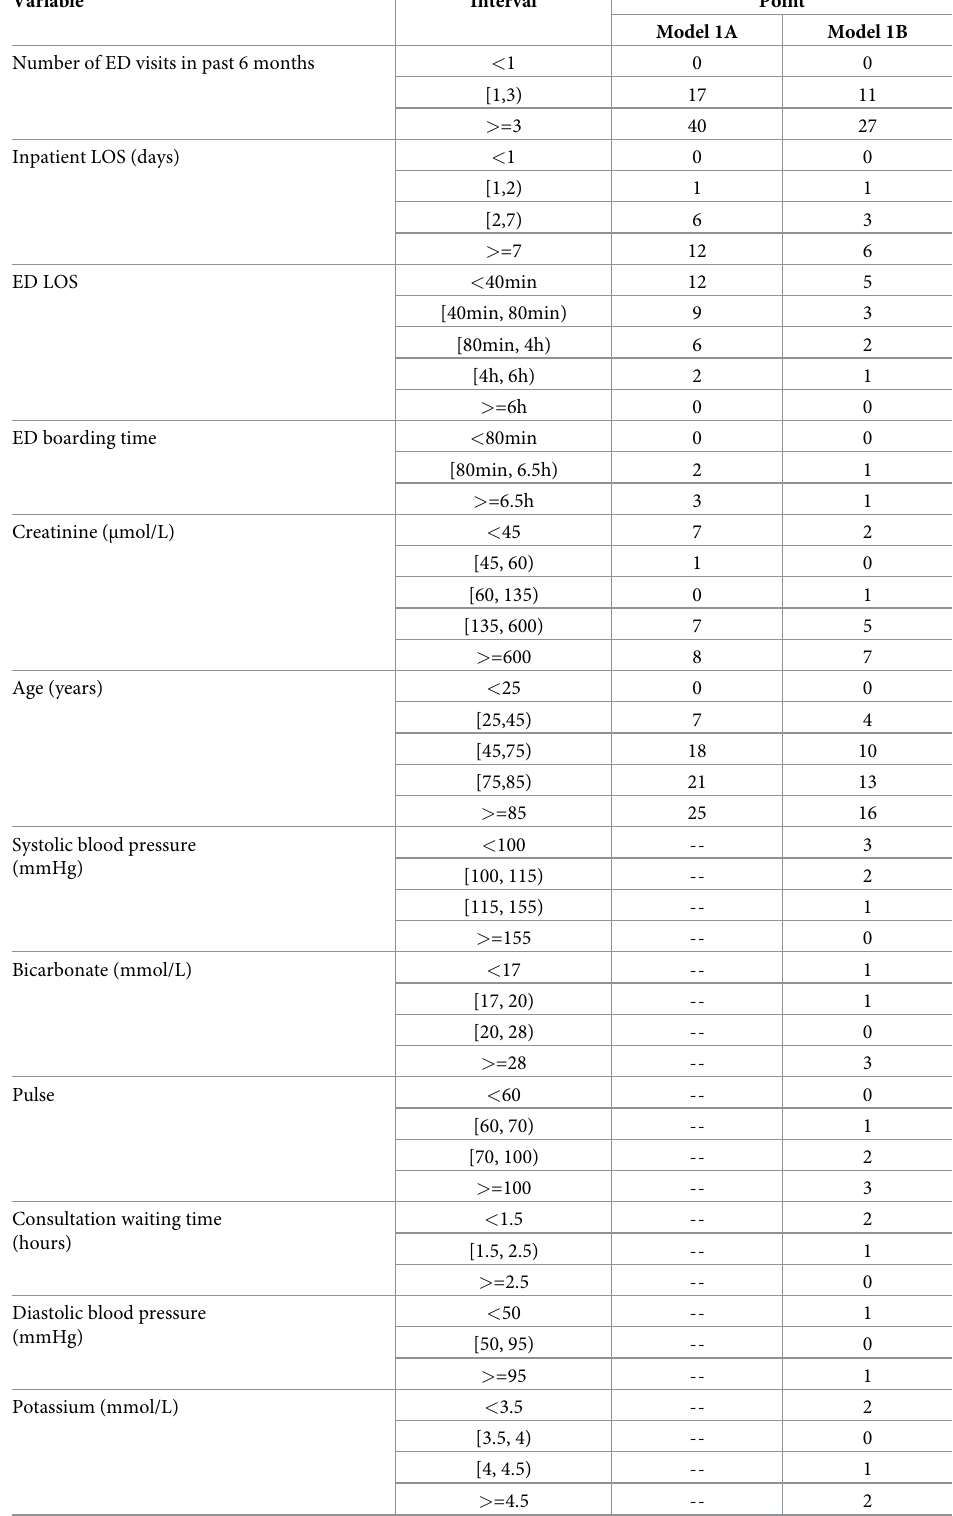
Table 3. Scoring tables of Models 1A and 1B generated using AutoScore, with variables ranked by random